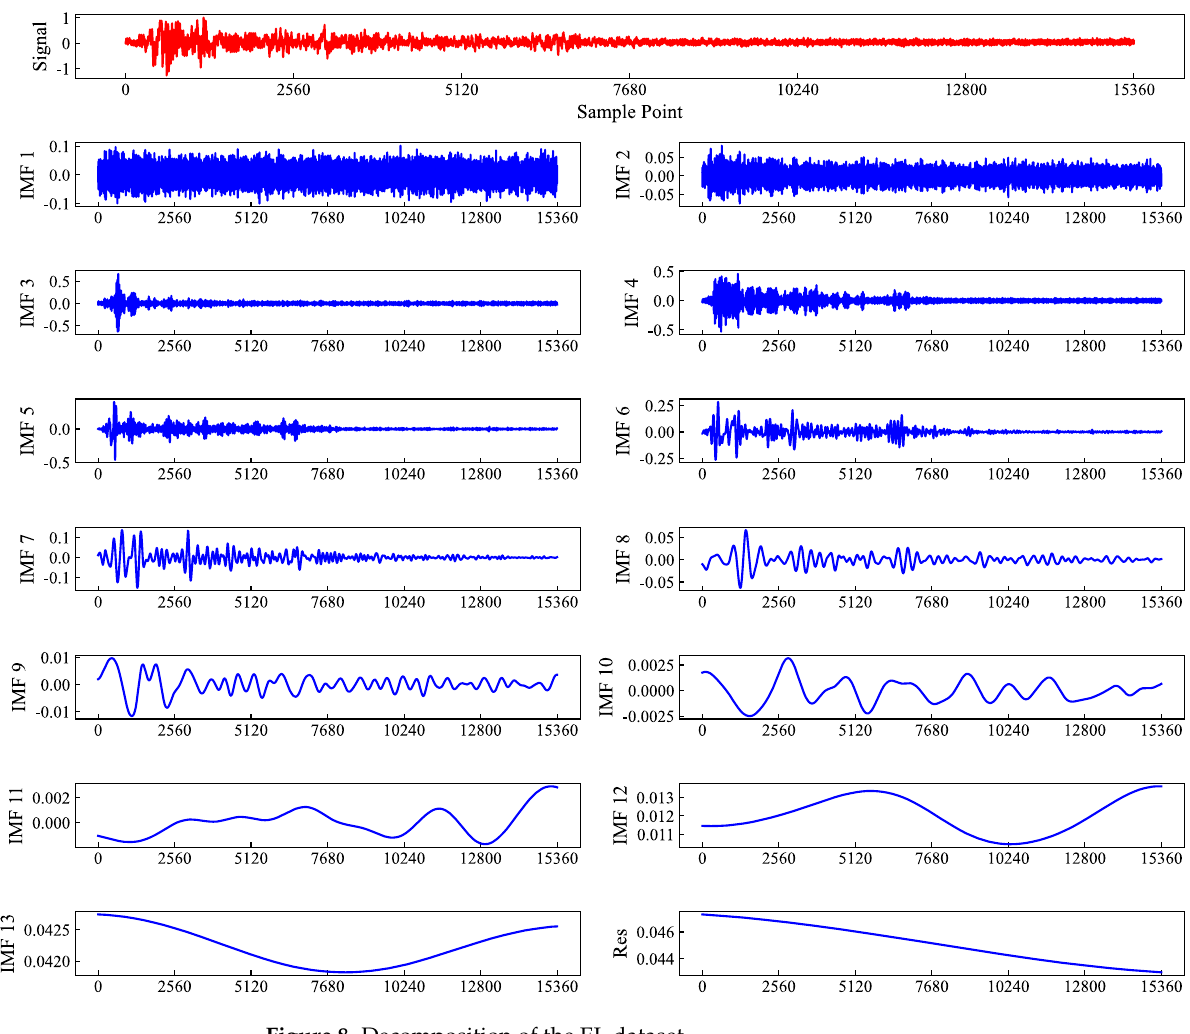
Figure 8. Decomposition of the EL dataset.